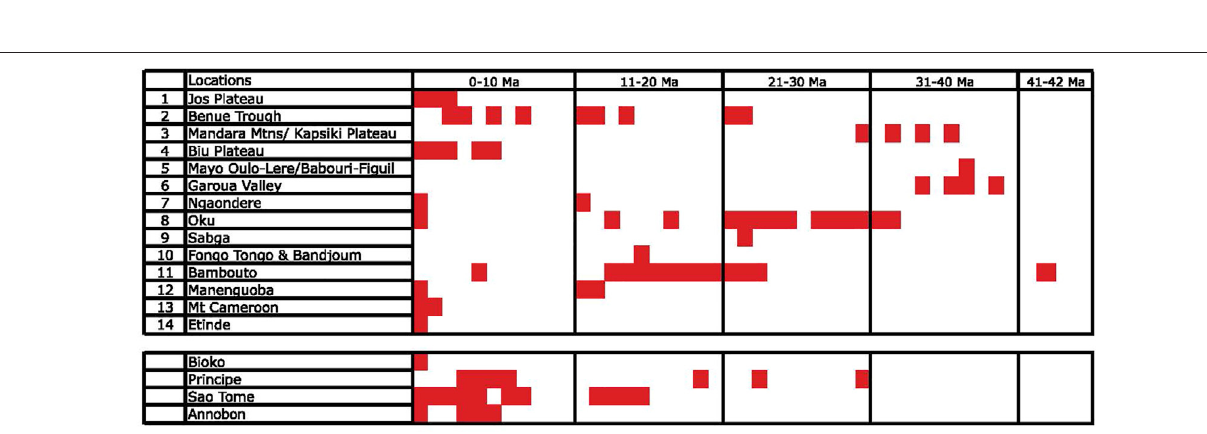
Frontiers in Earth Science |